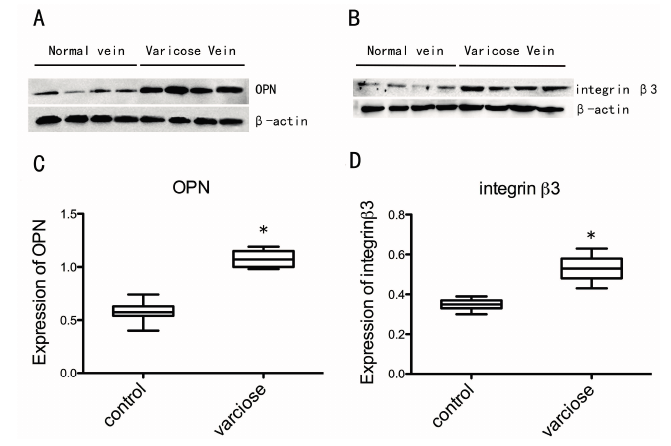
Figure 5. Western blots showing the expression of OPN and integrin β 3 in varicose veins compared with normal veins. Expression of OPN ( A ) and integrin β 3 ( B ) in the intima of vein specimens; Differences in OPN ( C ) and integrin β 3 ( D ) expression in the intima of vein specimens. Data are presented as medians and inter-quartile ranges ( * p < 0.0001 vs. Normal